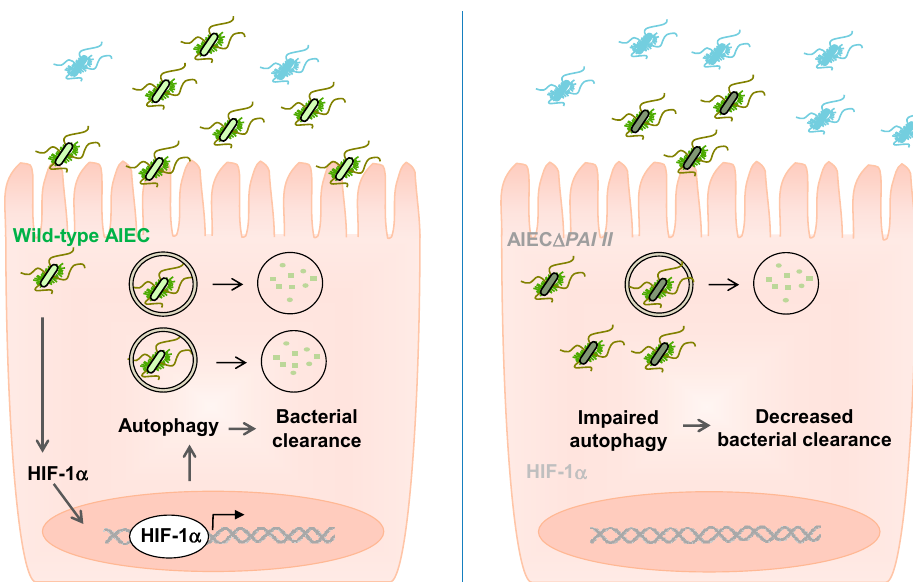
Figure 7. Hypothetical model for the involvement of PAI II in the interaction of AIEC with intestinal epithelial cells. Left panel: PAI II confers AIEC a high ability to compete with other bacteria for growth and adhesion to IECs. AIEC PAI II-encoded yersiniabactin activates autophagy via a HIF-1 α -dependent mechanism, leading to bacterial clearance. Right panel: AIEC invalidated for PAI II (AIEC ∆ PAI II ) have a lower ability to compete with other bacteria for adhesion to intestinal epithelial cells. Autophagy in IECs infected with AIEC ∆ PAI II is reduced, leading to impaired bacterial clearance, compared to that in IECs infected with wild-type AIEC. Thus, the presence of yersiniabactin, which is an advantage for AIEC to grow in a competitive environment, could be a disadvantage for the bacteria, as it activates autophagy-mediated bacterial clearance.